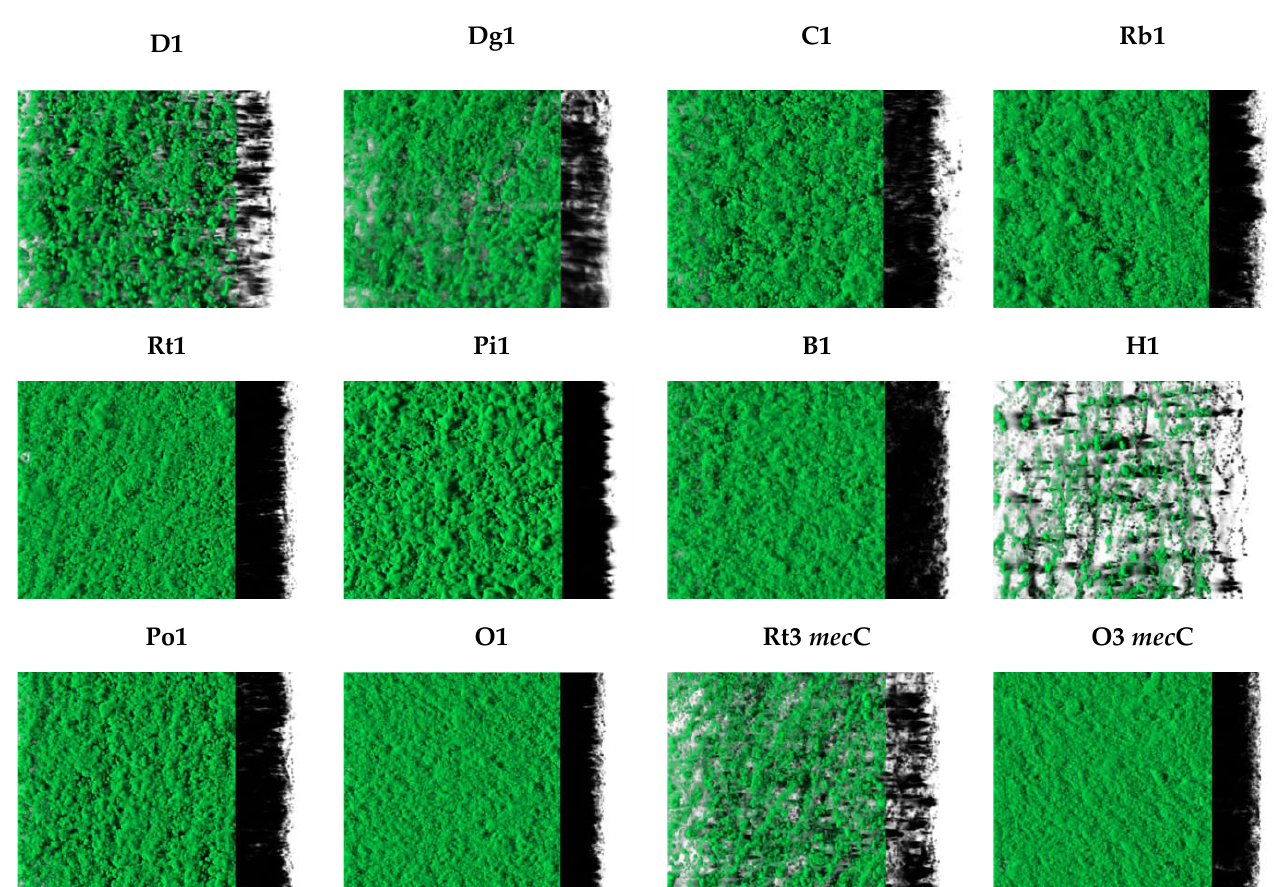
Figure 2. The images (126.8 µ m × 126.8 µ m) correspond to three-dimensional reconstructions obtained by CLSM and processed with the IMARIS 9.1 software, including the virtual projections of the shadows on the right. D: donkey; Dg: dog; C: camel; Rb: rabbit; Rt: rodent; Pi: pig; B: bovine; H: hare; Po: poultry; O owl.